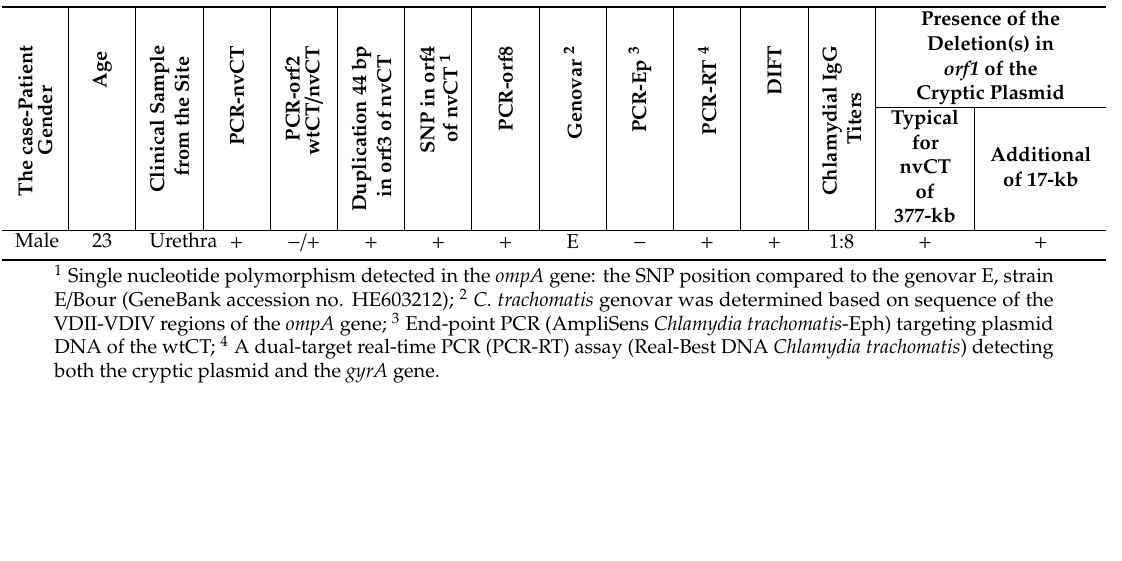
Table 1. Detection of Chlamydia from the